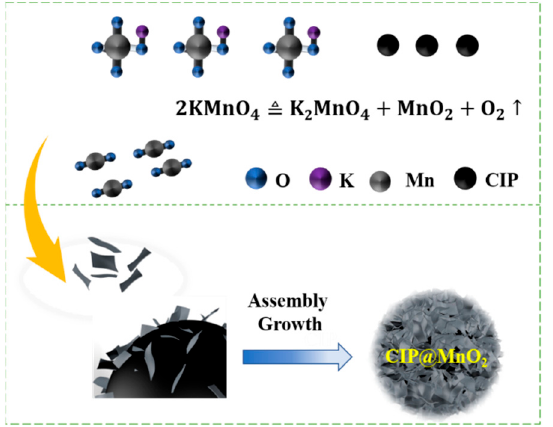
Figure 1. Schematic diagram of the synthesis of the CIP@MnO 2 core–shell